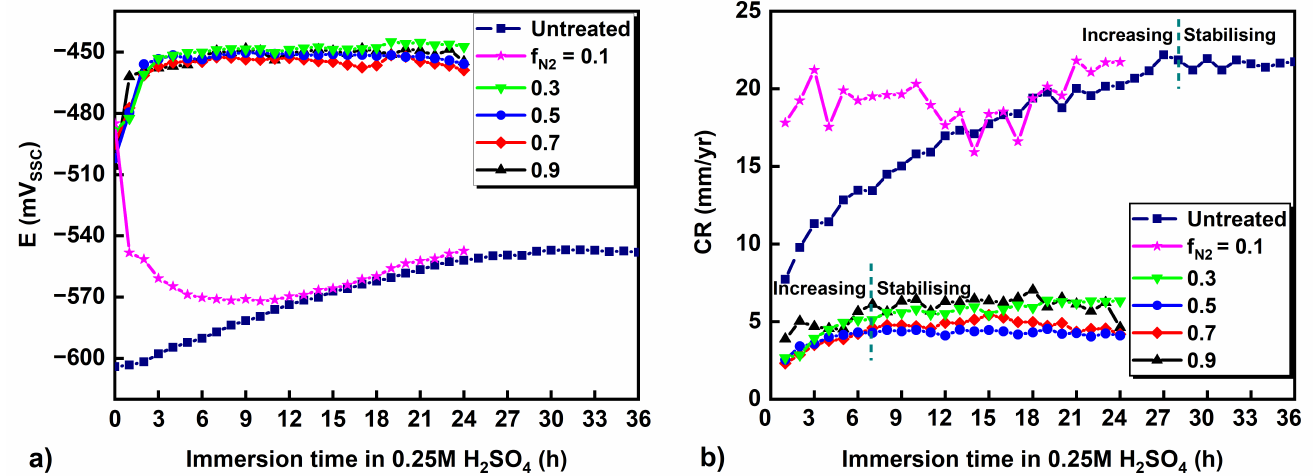
Figure 6. Time-dependent development of electrochemical parameters of non-nitrided and nitrided samples immersed in 0.25 M H 2 SO 4 for up to 24 and 36 h, respectively: ( a ) corrosion potential (E corr ) and ( b ) corrosion rate